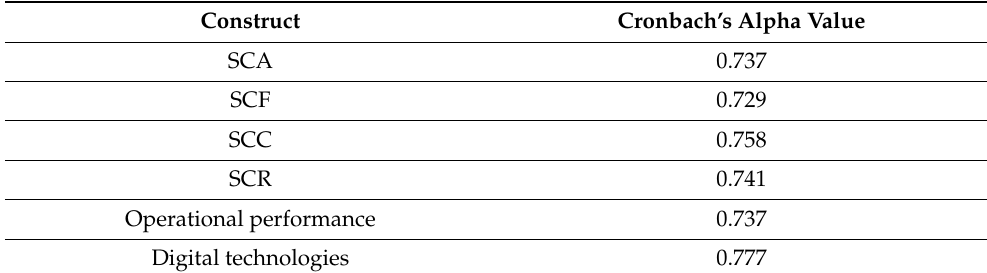
Table 7. Cronbach alpha for instrument constructs.